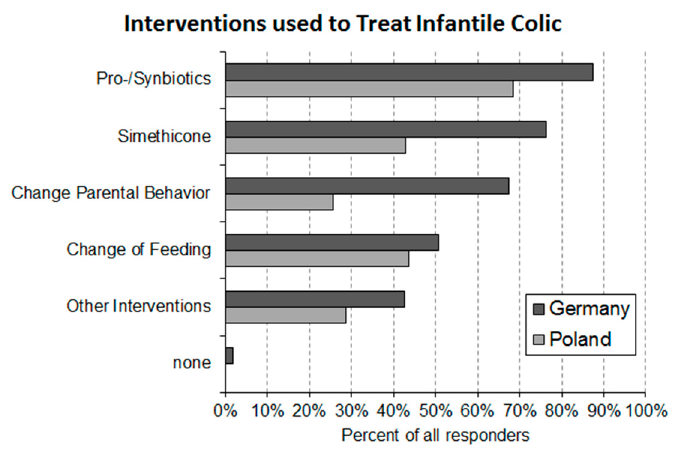
Figure 6. Interventions employed by German ( n = 160) and Polish ( n = 133) pediatricians for the treatment of infantile colic.